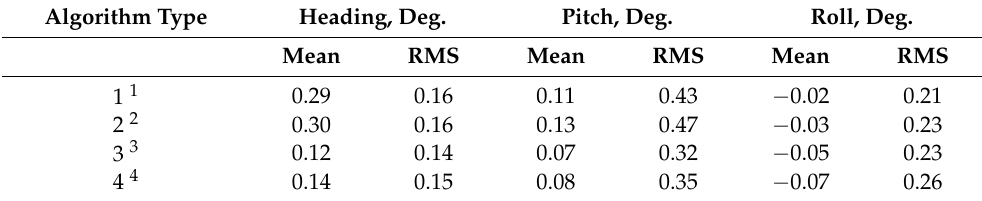
Table 1. Attitude errors mean values and RMS in car test.